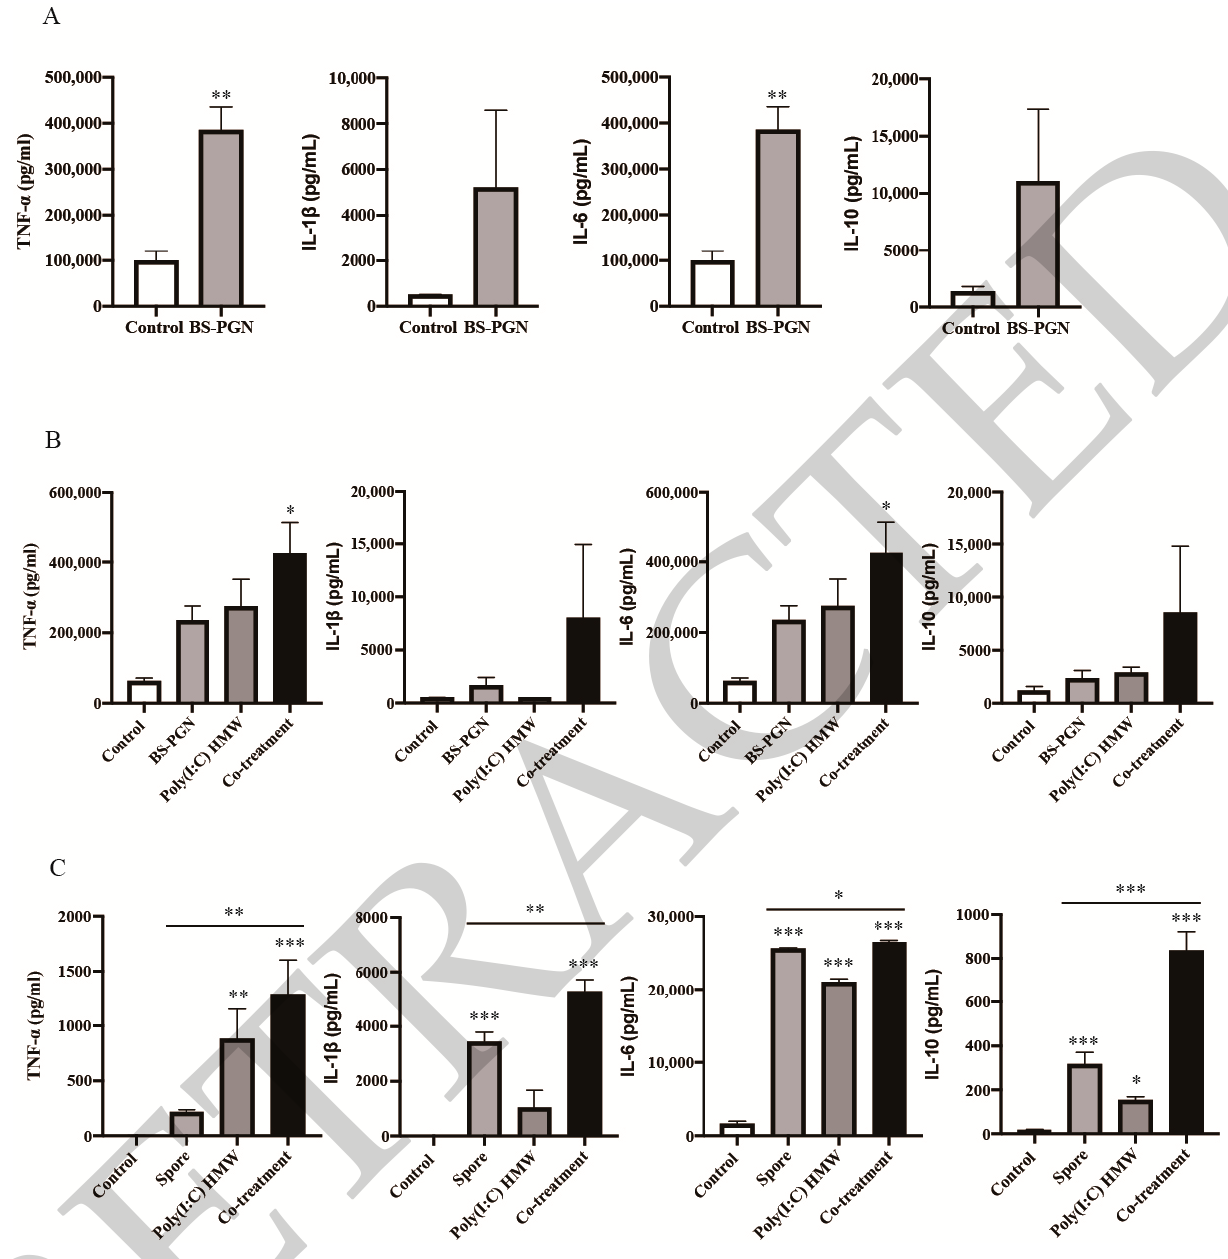
Figure 3. ( A ) Dendritic cell cultures were treated with peptidoglycan from B. subtilis (PGN-BS, 2.5 µg/mL) or PBS for 48 h, and the cell media were collected for cytokine profiling. Proinflammatory factor (TNF- α , IL-1 β , IL-6, and IL-10) concentrations from dendritic cells were measured. Number of independent experiments = 3. ( B ) Dendritic cell cultures were co-treated with PGN-BS and/or Poly(I:C) HMW for 48 h, and the cell media were collected for cytokine profiling. Proinflammatory factor (TNF- α , IL-1 β , IL-6, and IL-10) concentrations from dendritic cells were measured. Number of independent experiments = 3. ( C ) Dendritic cell cultures were co-treated with recombinant spores and/or Poly(I:C) HMW for 48 h, and the cell media were collected for cytokine profiling. Proinflammatory factor (TNF- α , IL-1 β , IL-6, and IL-10) concentrations from dendritic cells were measured. Data presented as mean ± SEM. Number of independent experiments = 6. * p < 0.05, ** p < 0.01, *** p < 0.001, one-way ANOVA with Tukey’s post hoc test. recombinant B. subtilis spores in mice. Eight-week-old BALB/c mice ( n = 4) were orally administrated with B. subtilis spores expressing CotC-sRBD for three courses (days 1–3, days 14–16 and days 28–30), and blood samples were drawn at days 0, 8, 22, and 38 (Figure